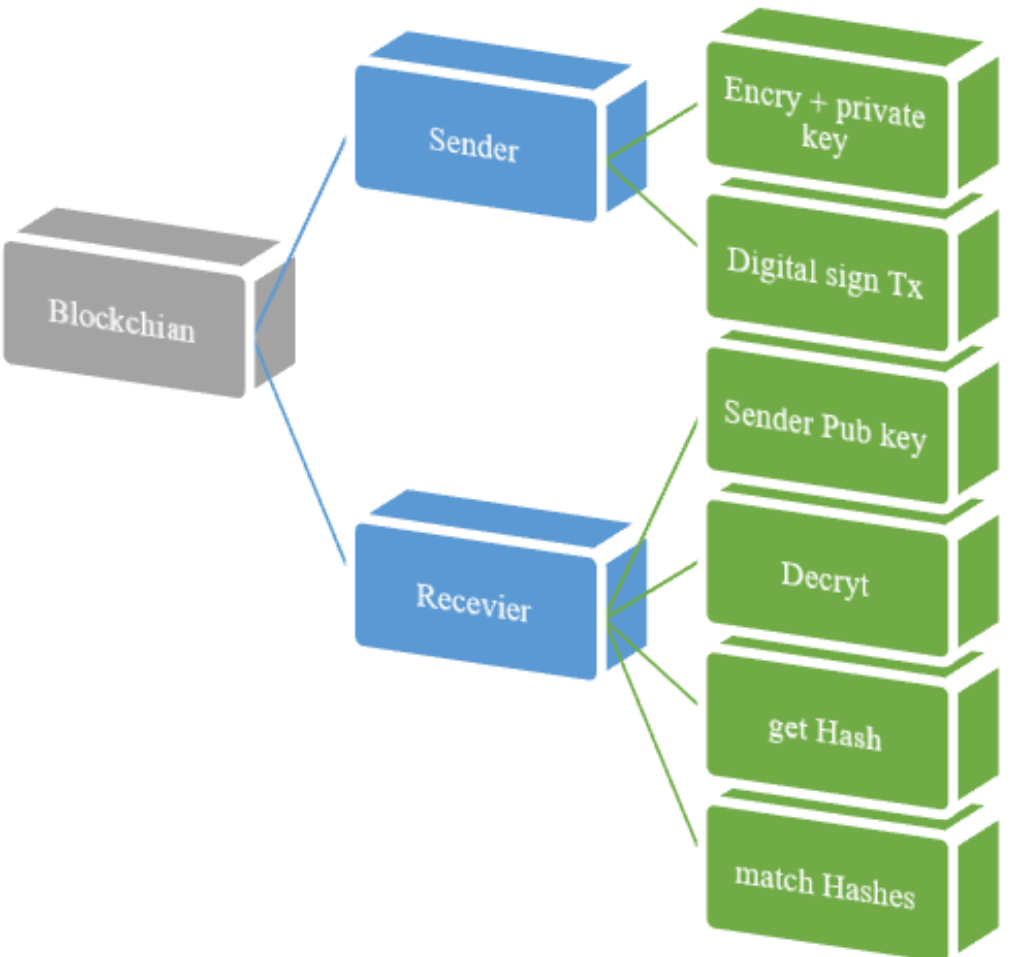
Figure 10. The signature being used for authentication.